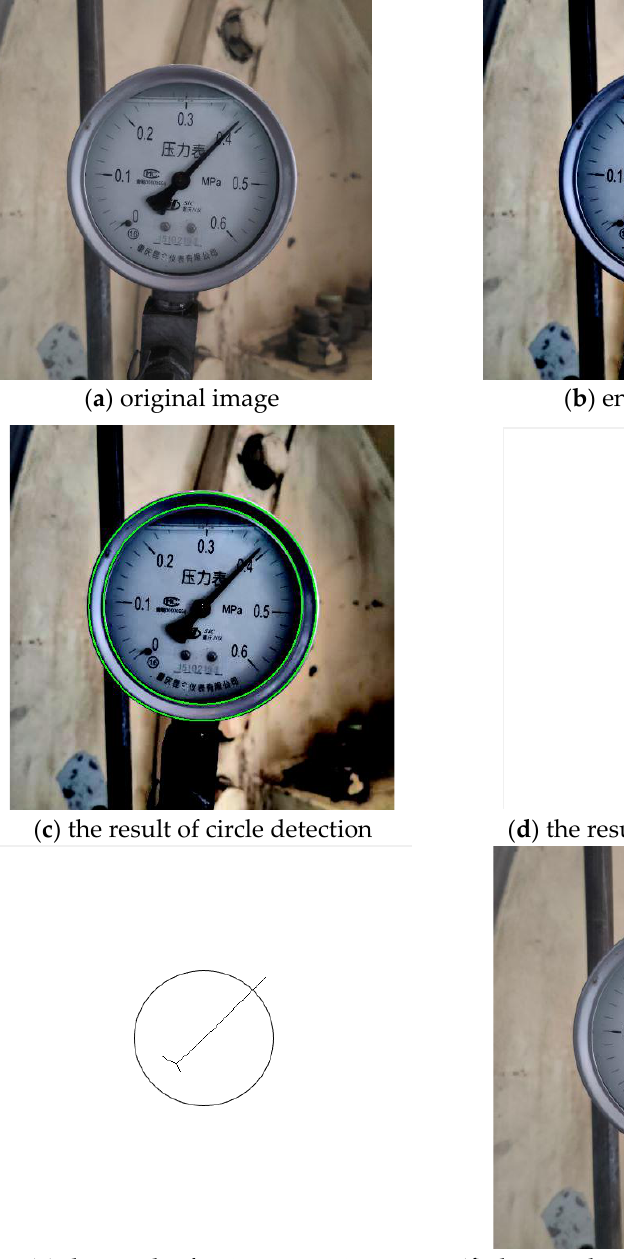
Figure 6. The algorithm detection result.